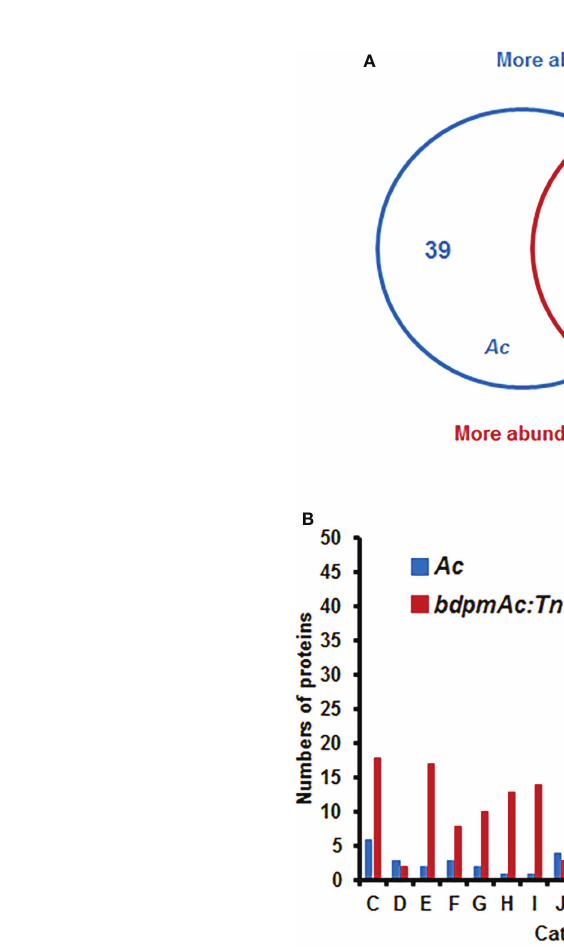
FIGURE 3 Comparative proteomic analysis between Ac and bdpmAc:Tn . (A) Venn diagram of the differentially (over two-fold change) abundant proteins identi fi ed in the comparative proteomic analysis. A total of 39 and 137 proteins were only found in Ac and bdpmAc:Tn , and 11 and 52 proteins were more abundant in these strains, respectively. (B) Categorization of the differentially abundant proteins using the clusters of orthologous groups (COGs). Abbreviations:C, Energy production and conversion; D, Cell cycle control and mitosis; E, Amino acid metabolism and transport; F, Nucleotide metabolism and transport; G, Carbohydrate metabolism and transport; H, Coenzyme metabolism; I, Lipid metabolism; J, Translation; K, Transcription; L, Replication and repair; M, Cell wall/membrane/envelop biogenesis; N, Cell motility; O, Post-translational modi fi cation, protein turnover, chaperone functions; P, Inorganic ion transport and metabolism; Q, Secondary structure; S, Function unknown; T, Signal transduction; U, Intracellular traf fi cking and secretion; V, Defense